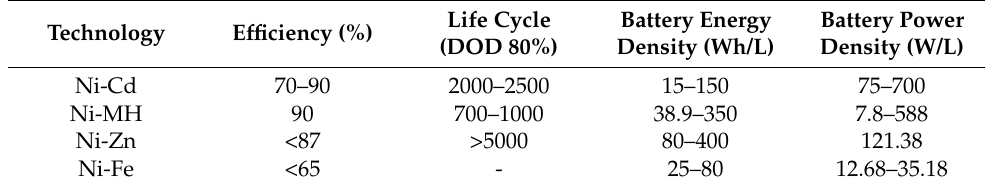
Table 8. Specification of technology nickel batteries